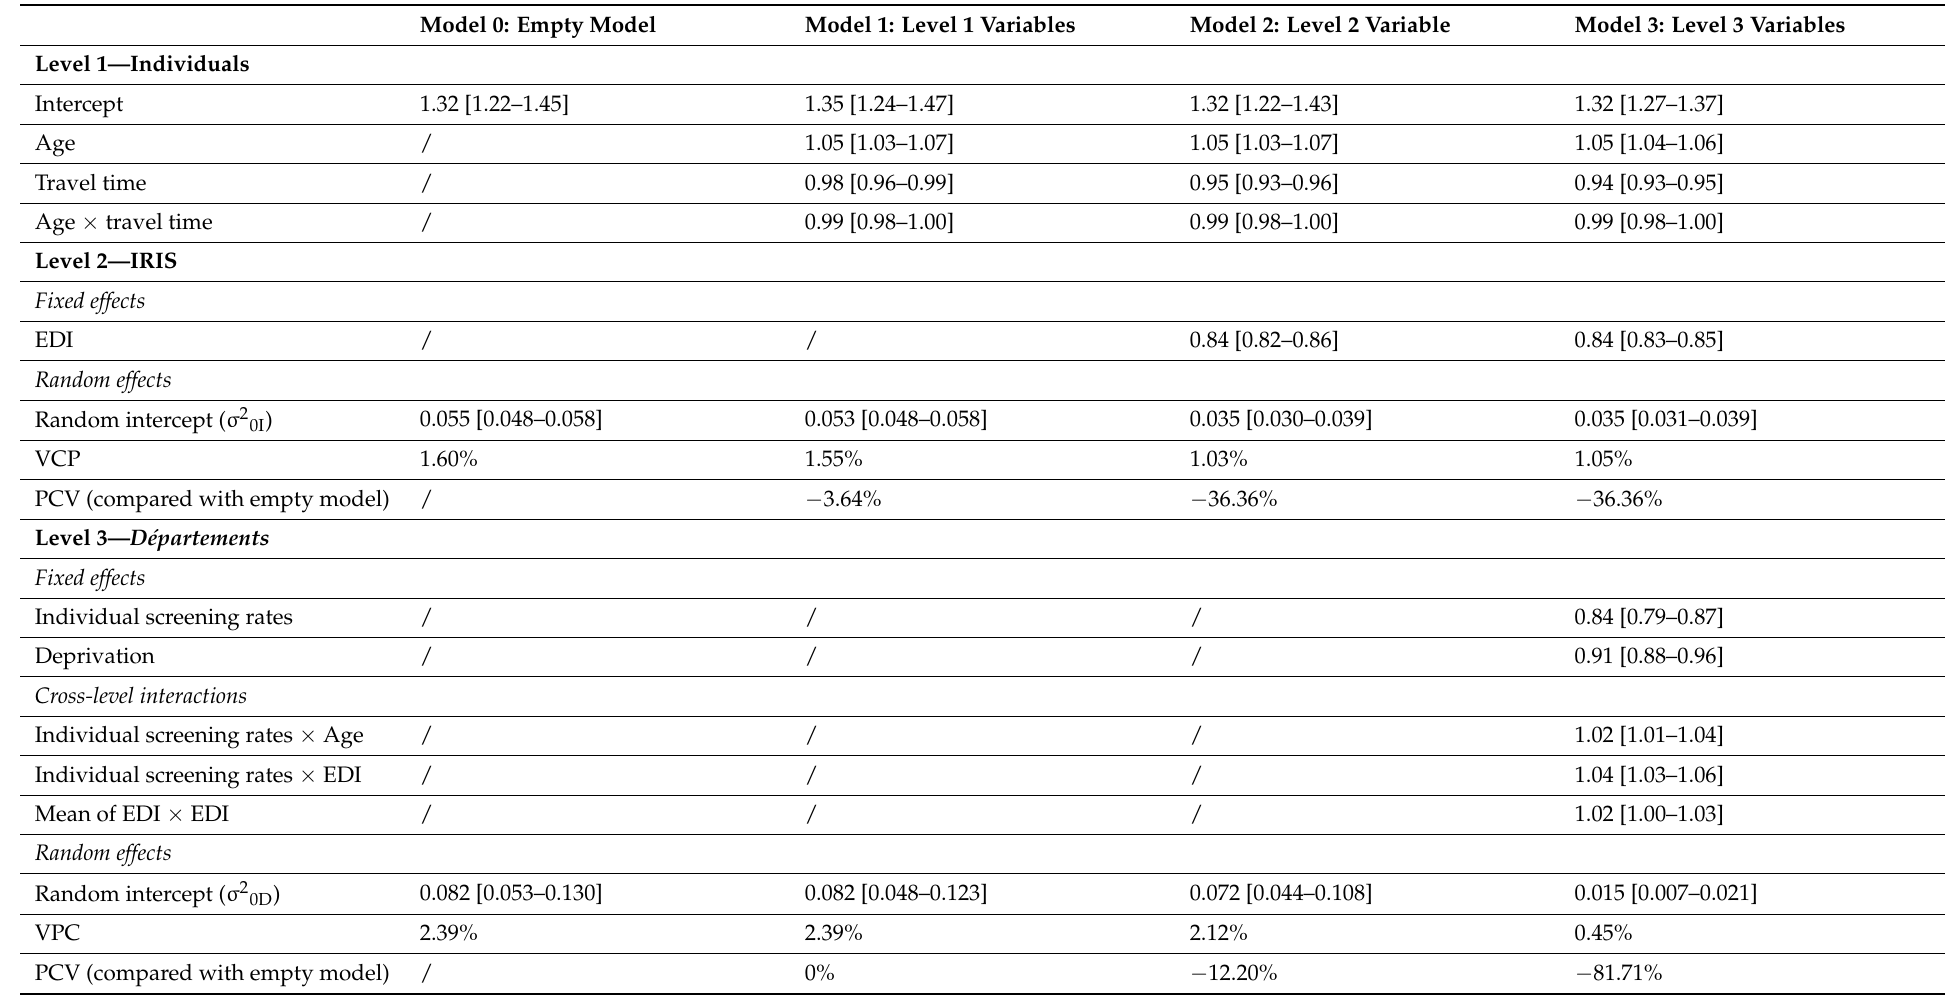
Table 2. Individual and contextual factors associated with French National Breast Cancer Screening Programme